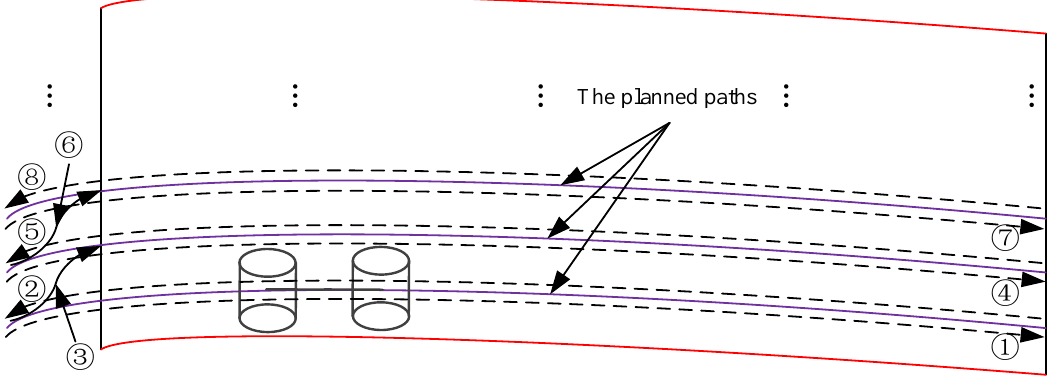
Figure 2. The articulated road roller tracks the planned paths in sequence form ① to ⑧ , where ① , ④ and ⑦ indicate that the roller is moving forward; ② , ⑤ and ⑧ indicate that the roller is driving in reverse; and ③ and ⑥ indicate that the roller is turning to the next path.